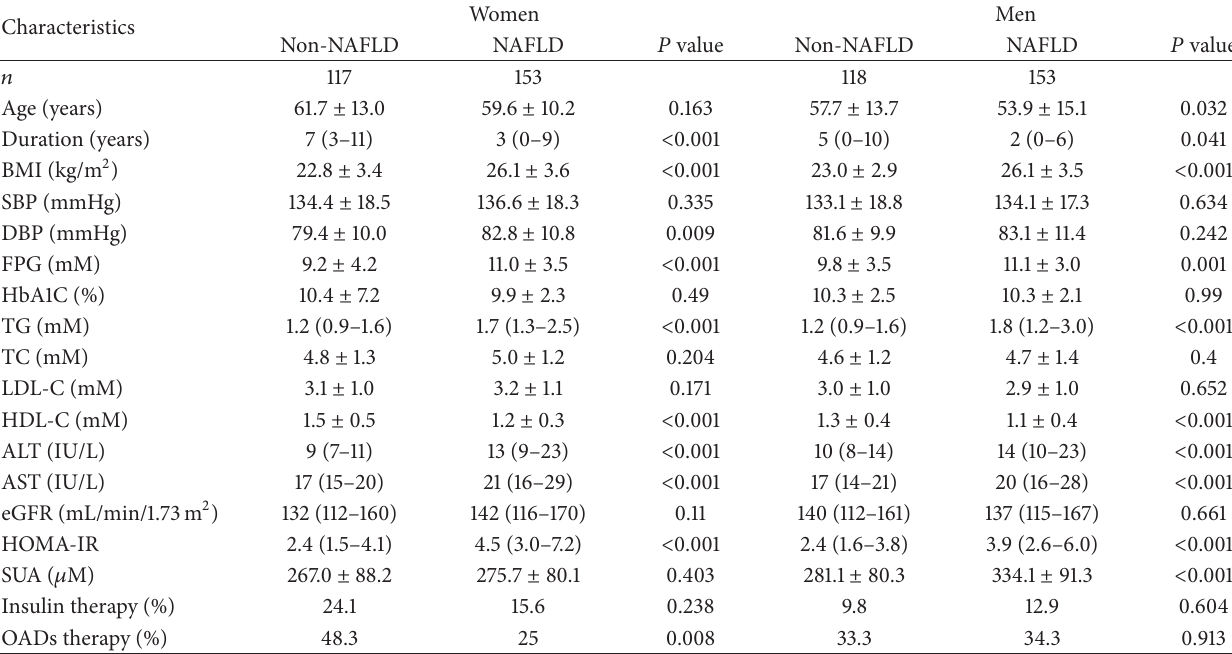
Table 1: Clinical and biochemical characteristics of the study subjects.